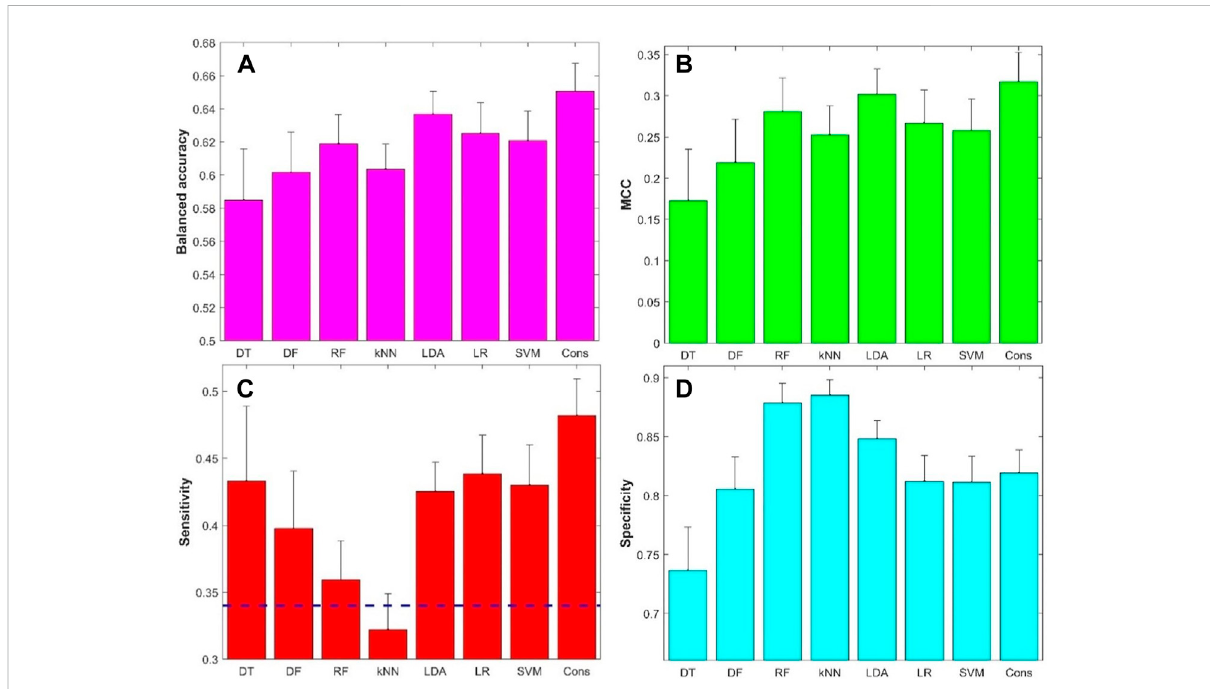
FIGURE 5 Results of 5-fold cross-validations: (A) Balanced accuracy, (B) Matthews correlation coef fi cient (MCC), (C) Sensitivity, and (D) Speci fi city. The x -axis indicates machine learning models and the y -axis represents performance metrics and starts from the performance of hypothetic random modelexceptforsensitivity (C) forwhichthehypotheticrandommodelmetricswasmarkedbythedashline.Theaverageperformancemetricsfrom the 500 iterations of 5-fold cross-validation were plotted as bars and the related standard deviations were given as sticks above the bars. The dash line in fi gure (C) represented 0.34, the ratio of positive compounds in all compounds. DT, decision tree; DF, decision forest; RF, random forest; kNN, k-nearest neighbors; LDA, linear discriminant analysis; LR, logistic regression; SVM, support vector machine; Cons, consensus